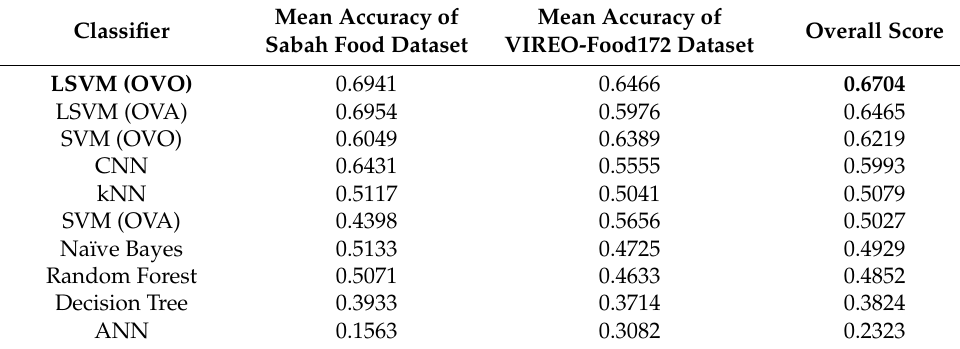
Table 23. The overall performance of classifiers.